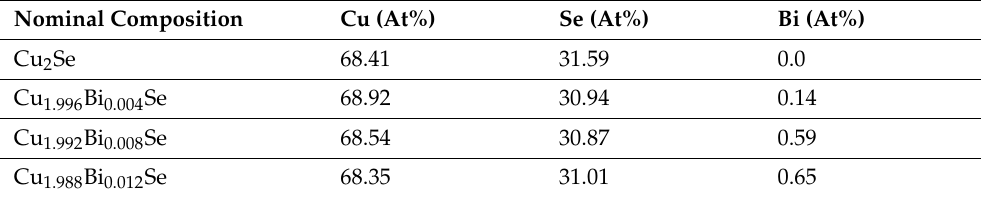
Table 3. EDS results of Cu 2 − x Bi x Se (x = 0.00, 0.004, 0.008, 0.012) samples. Nominal Composition